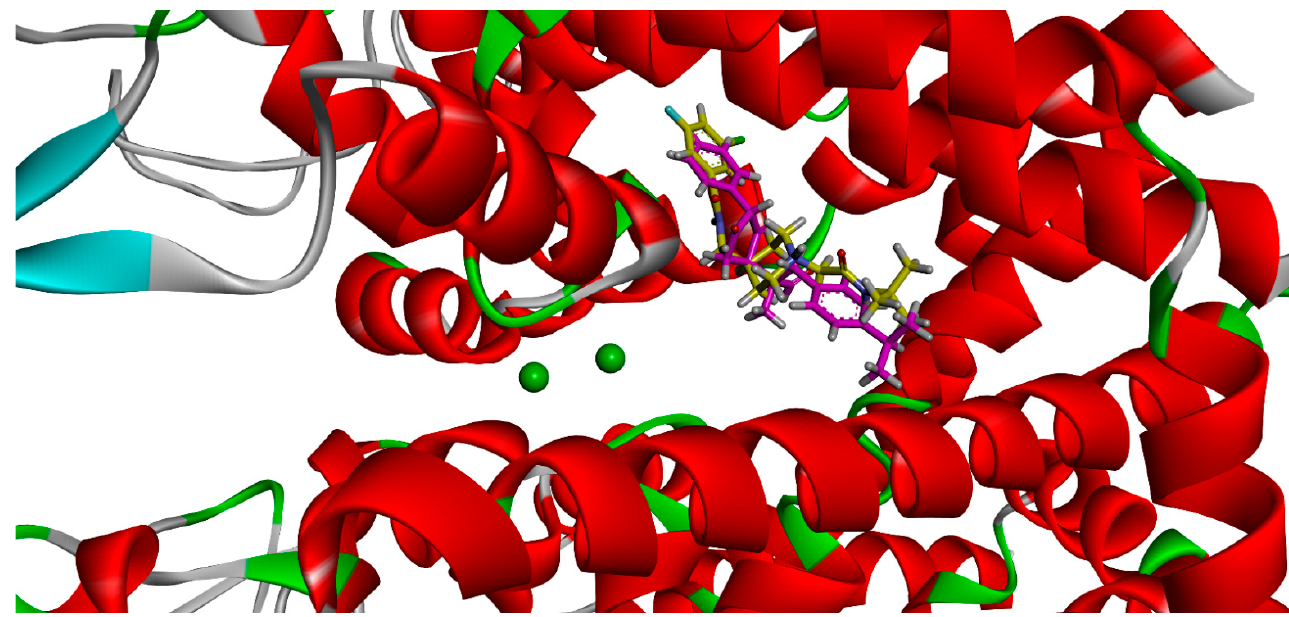
Figure 3. Superposed diagram of native ligand (yellow) and succinimide derivative (pink) R,S-1 in the binding site of 6KZP .